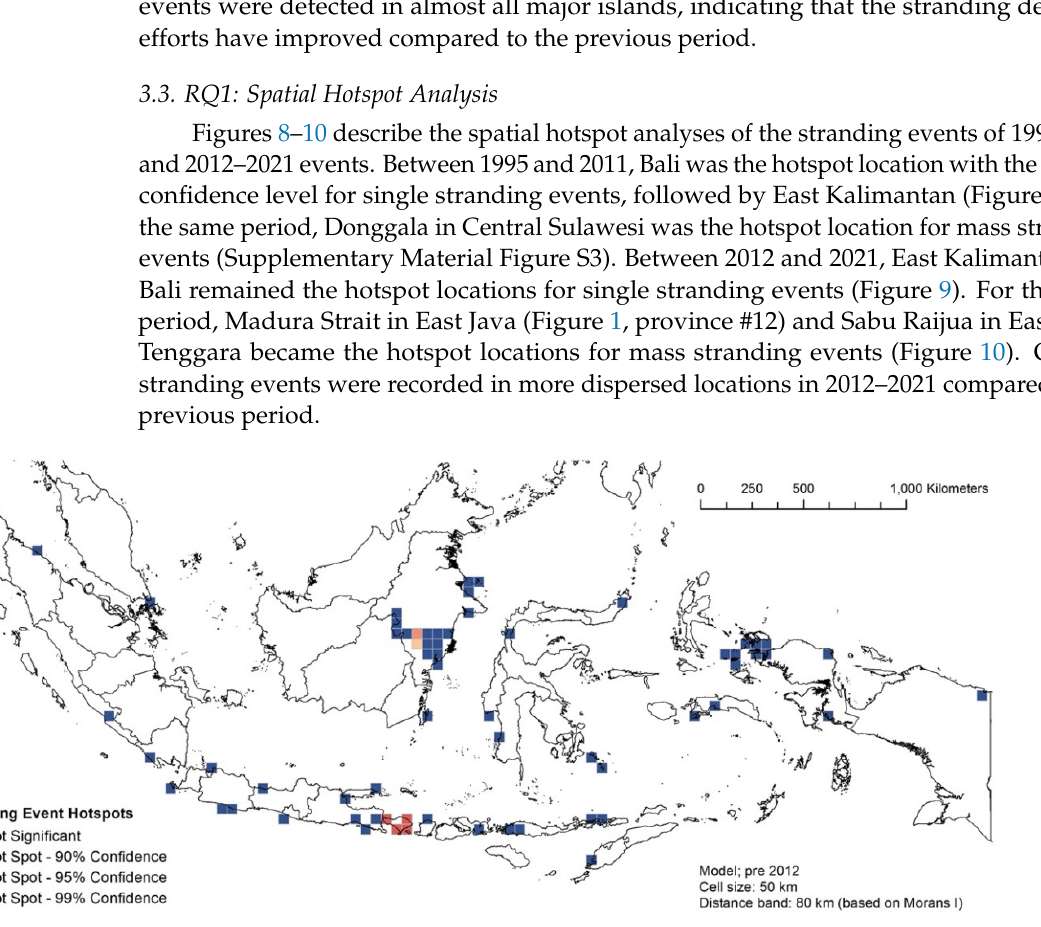
Figure 8. The spatial hotspot analysis of single stranding events of 1995–2011.